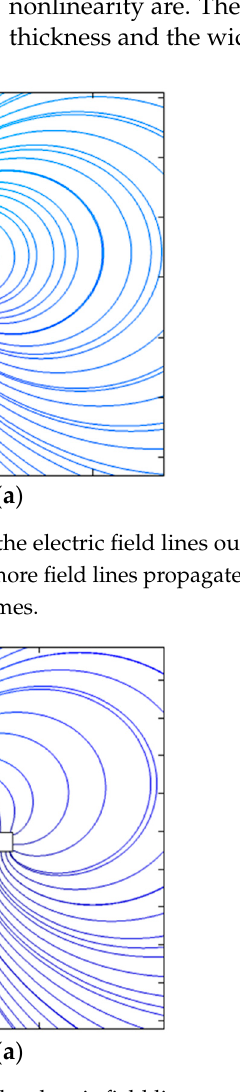
Figure 17. Propagation of the electric field lines outside the capacitor for ( a ) a small probe guard ring and ( b ) a large probe guard ring. The wider the guard ring, the more field lines propagate into the electric far field in a less disturbed way, and the smaller the top stray capacitance becomes.